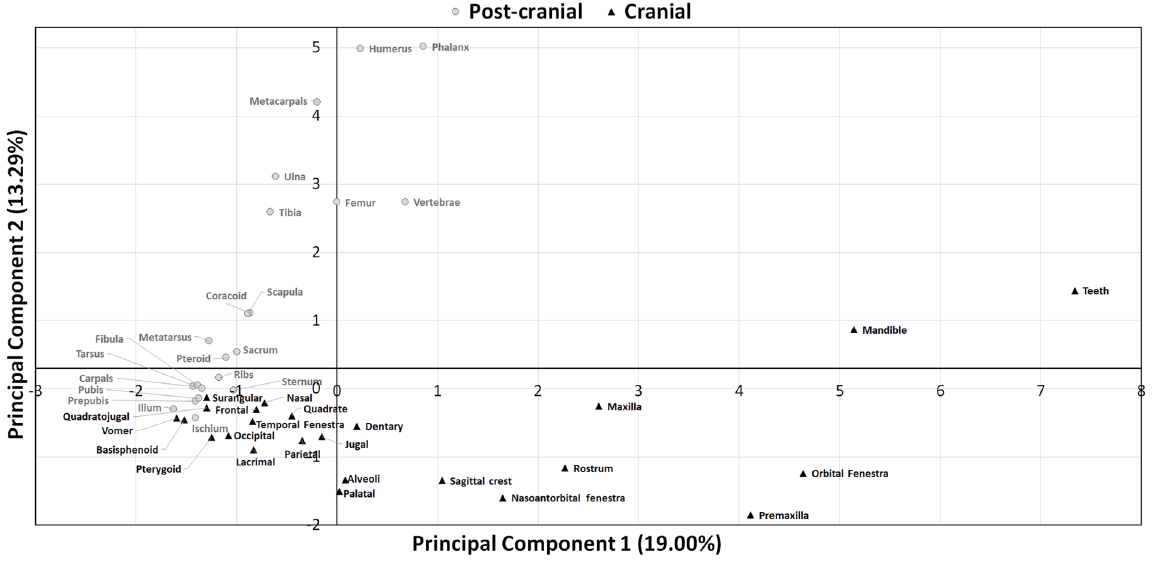
Figure 5. PCA scatter plot (PC1 and PC2) of the diagnostic signal of post-cranial (circle) and cranial (triangle) osteological